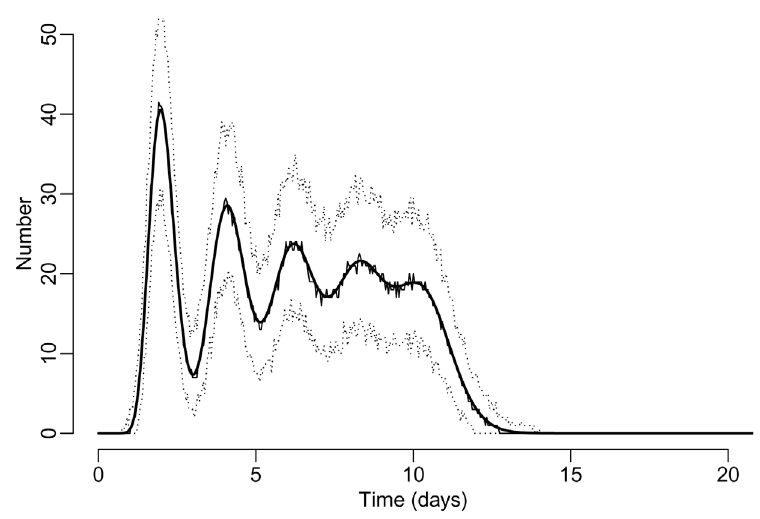
Figure 1. Number of individuals completing a development cycle in 20 days. Thick solid line indicates the mean trajectory from the deterministic simulation, while the thin solid line and the dotted lines indicate the median and the 95% range of the stochastic simulation output. The timestep for each iteration is one